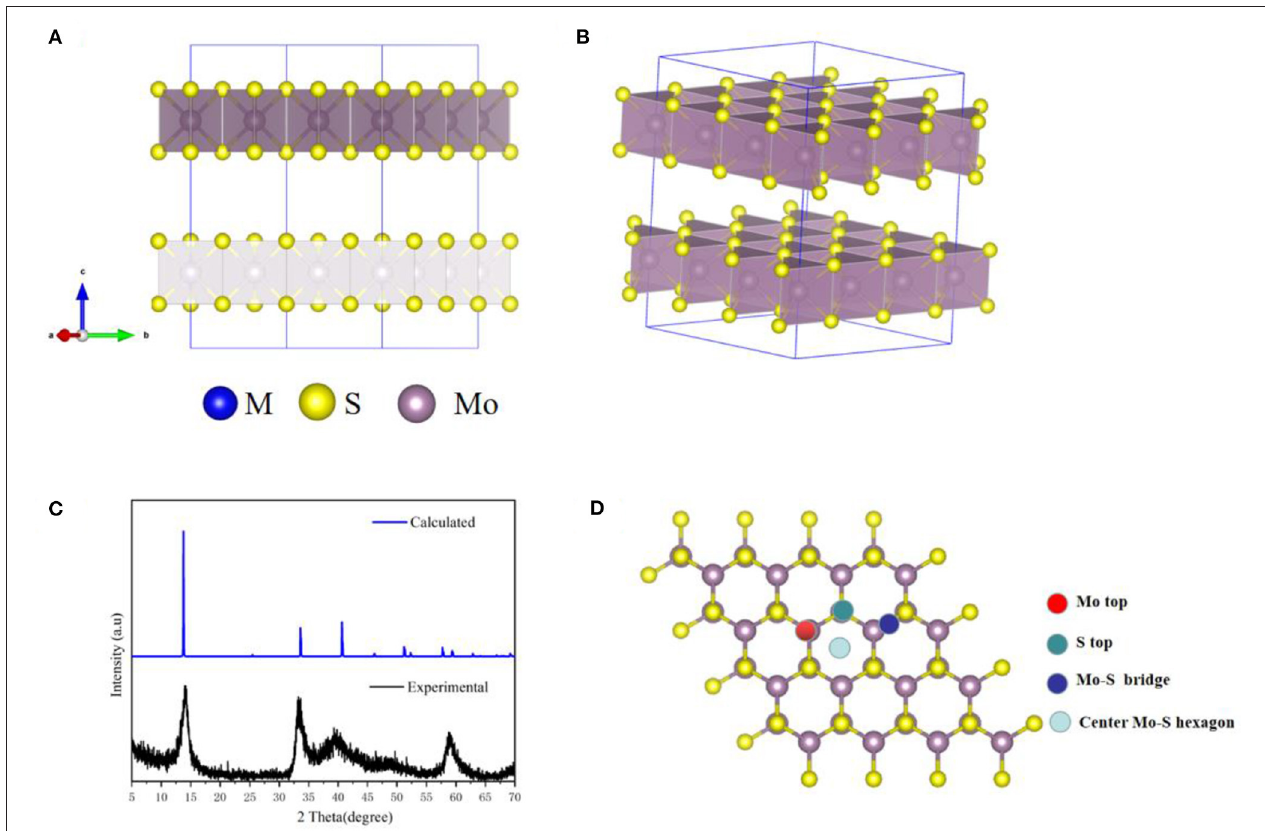
FIGURE 1 | The MoS 2 structure drawings viewed along (A) c-axis and (B) the stereo perspective. (C) The XRD pattern of the MoS 2 sample. (D) Adsorption site of